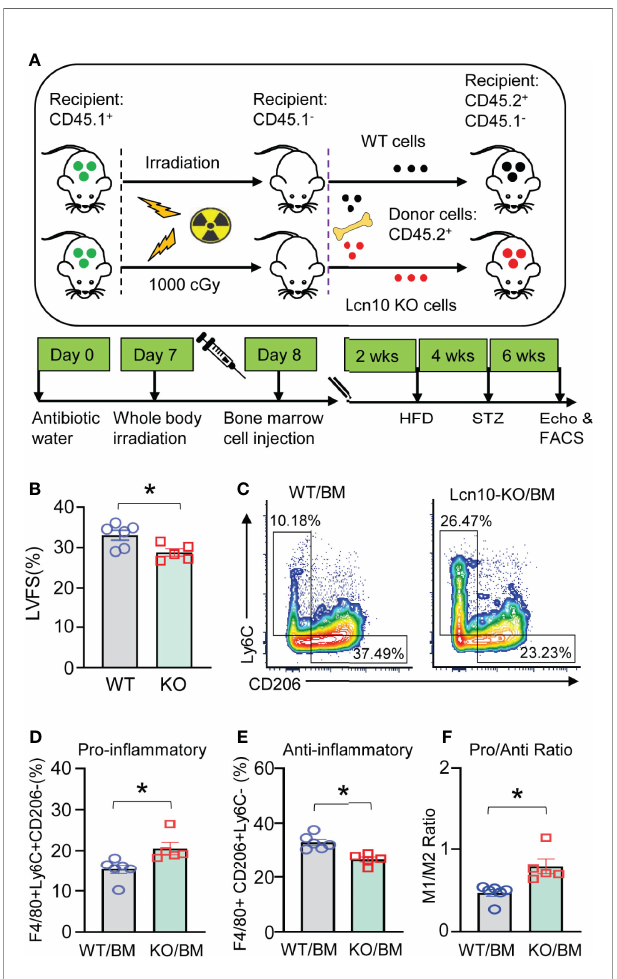
FIGURE 5 | Transplantation of Lcn10-KO bone marrow cells promotes more in fi ltration of pro-in fl ammatory macrophages in T2D hearts and results in worsened cardiac dysfunction. (A) Graphic scheme of bone marrow cell transplantation experiments. (B – F) LVFS (B) and cardiac macrophage phenotype (C – F) were determined 6 weeks after STZ administration (* P < 0.05, n = 5-6 mice per group). All data are presented as mean ± SEM and analyzed by student ’ s t-test.